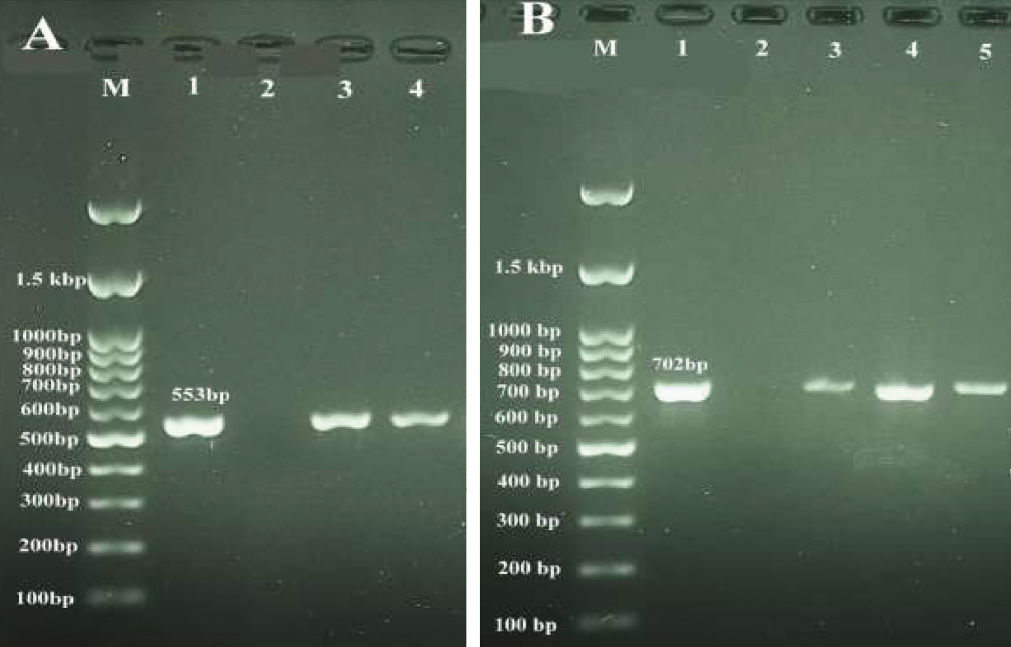
Figure 1: Touchdown PCR assay for the detection of Listeria spp. (a) and L. monocytogenes (b) in raw milk samples. A: Lane M: standard DNA marker; Lane 1: positive control; Lane 2: negative control; Lanes 3 and 4: positive samples for Listeria spp. B: Lane M: standard DNA marker; Lane 1: positive control; Lane 2: negative control; Lanes 3–5: positive samples for L. monocytogenes . Table 1: Distribution and prevalence of Listeria spp. and L. monocytogenes in milk samples. Listeria spp . L. Region Animal Number